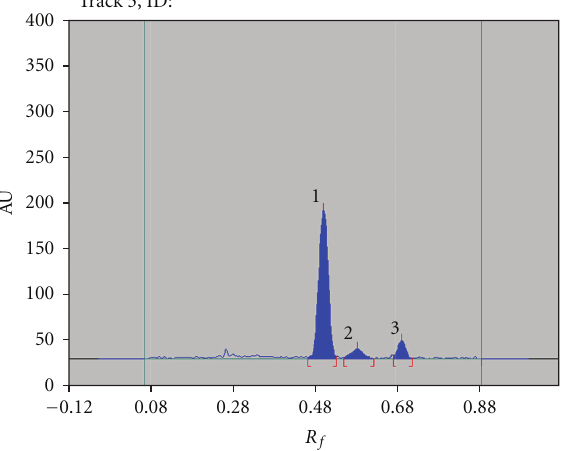
Figure 3: Densitogram of the photodegradation product 150 ng/spot; condition: white fluorescent and integrated near-ultra- violet energy at 1.2 million lux hours and 200 watts hours/sq · mts for 8h; Peak 1 (tenofovir disoproxil fumarate, R f : 0.50), Peak 2 (degraded, R f : 0.58), and Peak 3 (degraded, R f